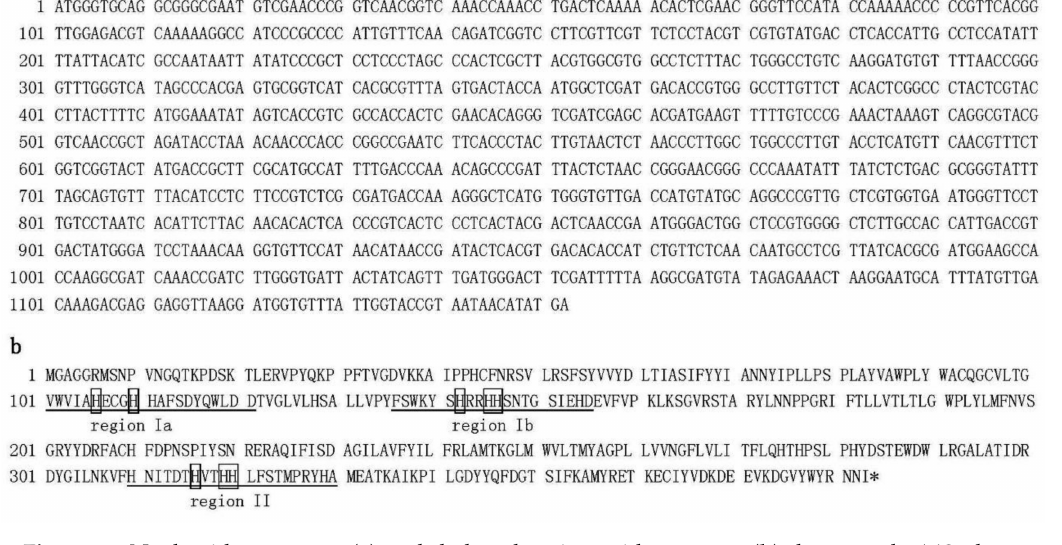
Figure 1. Nucleotide sequence ( a ) and deduced amino acid sequence ( b ) that encode ∆ 12-oleate desaturase (BPOD; accession number MF318524) from Bidens pilosa var. radiata . Eight conserved histidine residues are indicated in boxes. Three regions (region Ia, region Ib, region II) of catalytic sites are